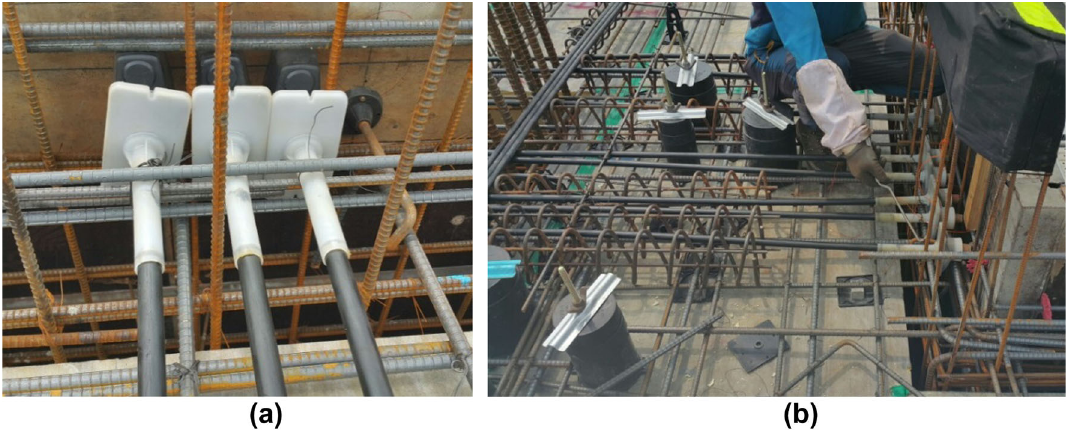
Fig. 13 Applications of developed encapsulated anchor systems. a Stressing end anchors and b fixed end